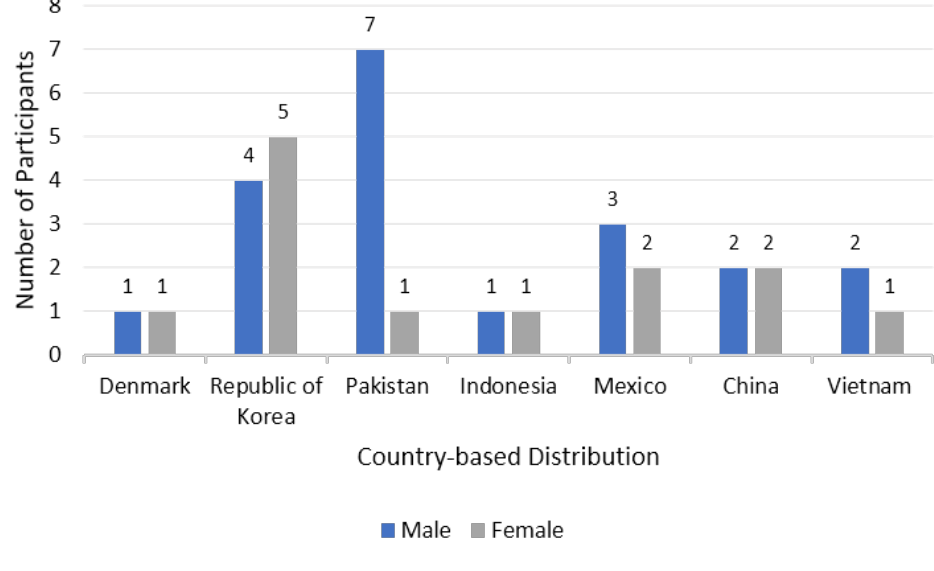
Figure 6. Country-based distribution of MIRA evaluation